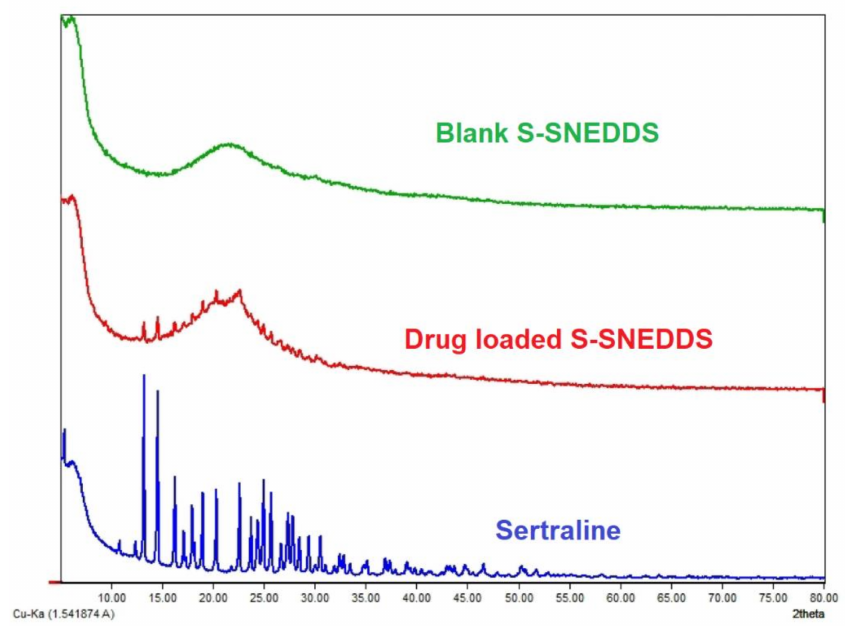
Figure 11. X-ray diffractogram of pure sertraline, prepared blank solid self-nanoemulsifying drug delivery system (S-SNEDDS) and drug-loaded